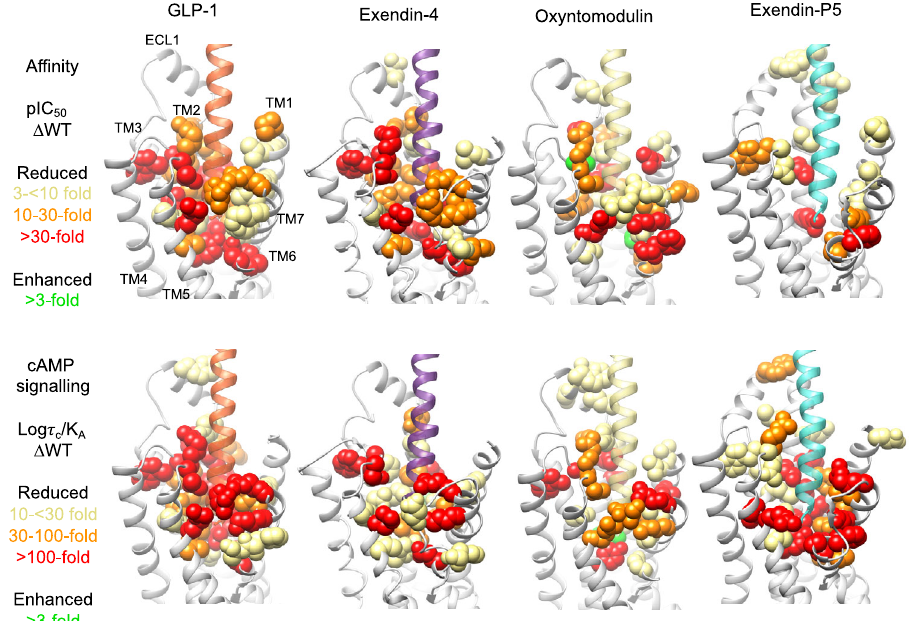
Fig. 4 Heat maps depicting the 3D representation of the effect of alanine mutation of residues within the TMD peptide-binding cavity on af fi nity and signalling. Models of the peptide bound GLP-1Rs showing residues (in space fi ll) that altered af fi nity (top) or signalling (bottom) of GLP-1, exendin-4, oxyntomodulin and exendin-P5 relative to the wild type receptor when mutated. These are coloured depending on their level of effect highlighted in the colour key. TM domains are labelled on the GLP-1-bound model depicting af fi nity changes, with the same receptor views used for the remaining